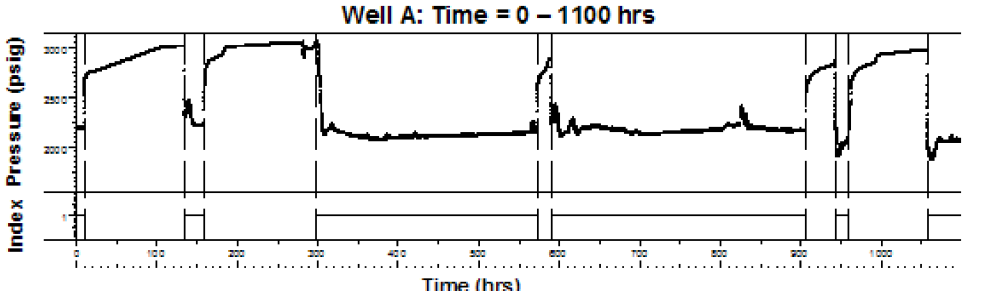
Figure 8. Detection result using the filter convolution method from Suzuki [33].